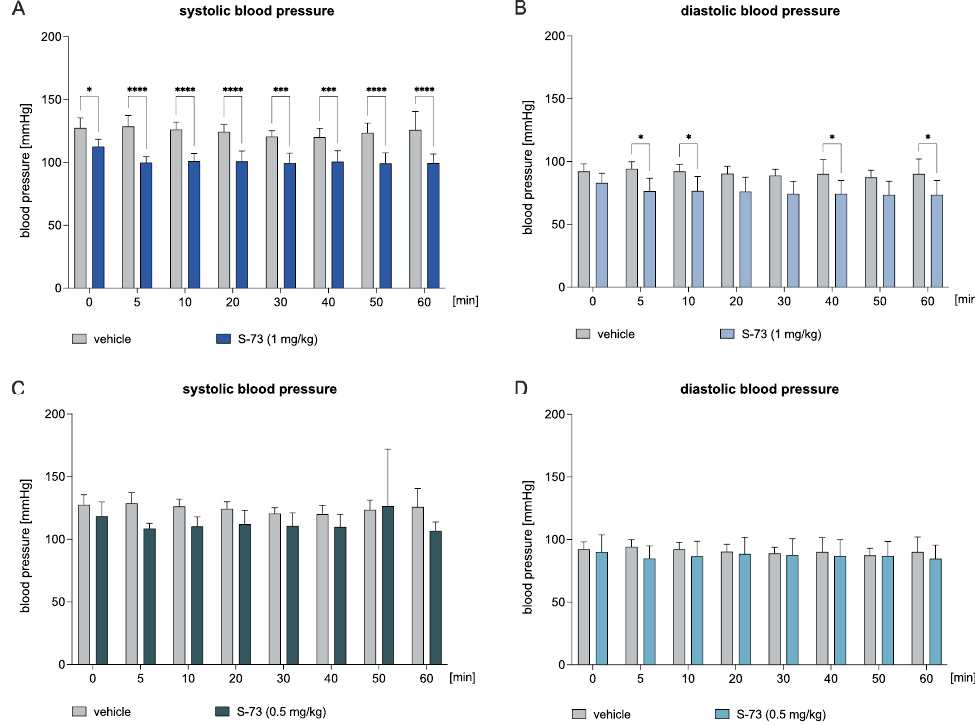
Figure 3. The effect of S-73 on the systolic (Panel A , C ) and diastolic blood pressure (Panel B , D ) in the normotensive rats. The blood pressure was measured before and 5, 10, 20, 30, 40, 50, and 60 min